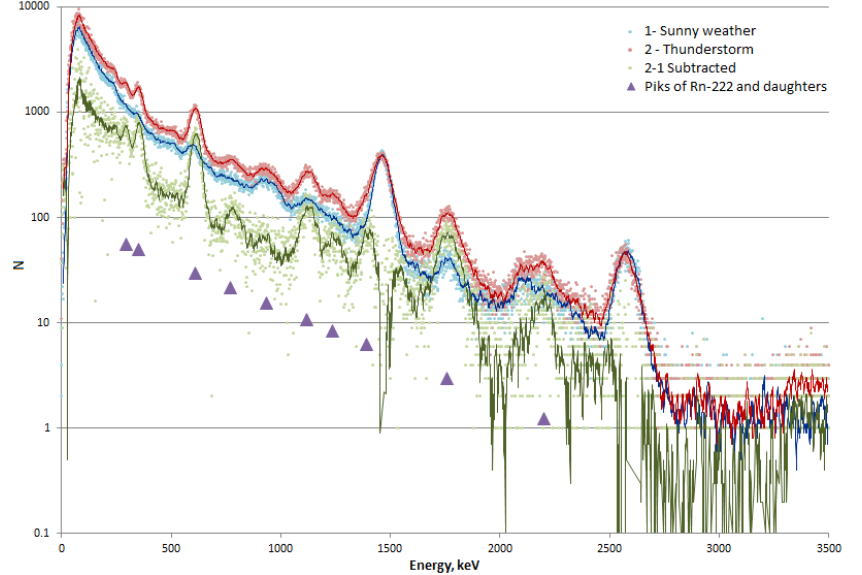
Fig. 4. Energy spectrum of atmospheric gamma rays detected on July 27, 2015 in the Moscow region during a thunderstorm and in clear